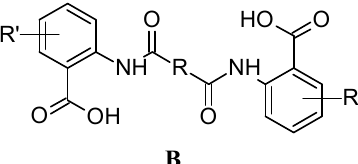
Figure 2. Acid-amide intermediate from anthranilic acid derivatives and a dichloride of a dicarboxylic